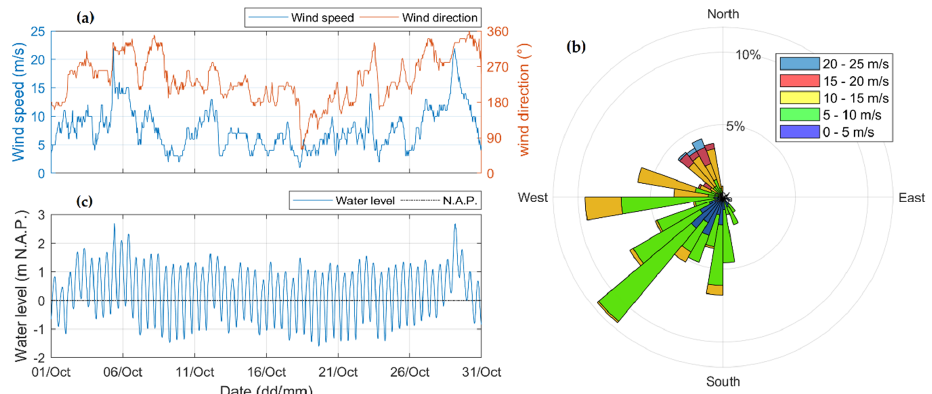
Figure 2. Observed hydrodynamic conditions during the simulated period nearby the study area.